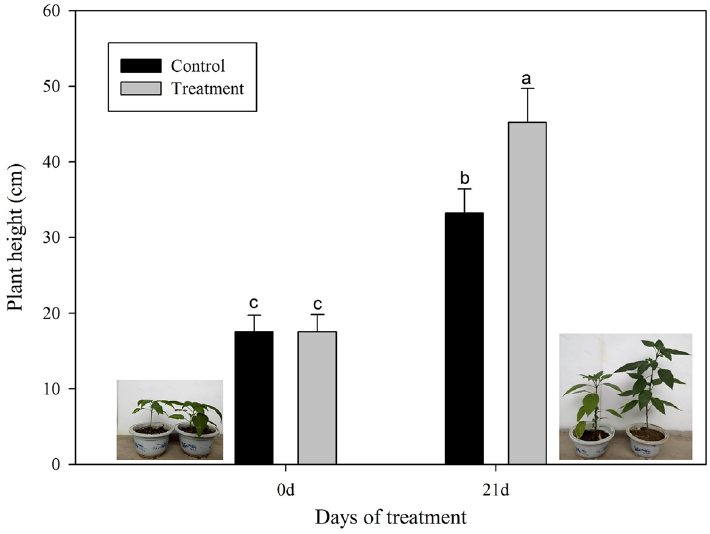
Figure 1. Effects of Chlorella extracts on the plant height of pepper. Plant height was measured on the 0 and 21th day after Chlorella extract treatment. Control: no Chlorella treatment; Treatment: plants were treated by Chlorella extracts; SAS analysis at 5% is shown in lowercase letters to indicate significant differences. Vertical bars in the figures represent ± SD of five independent biological